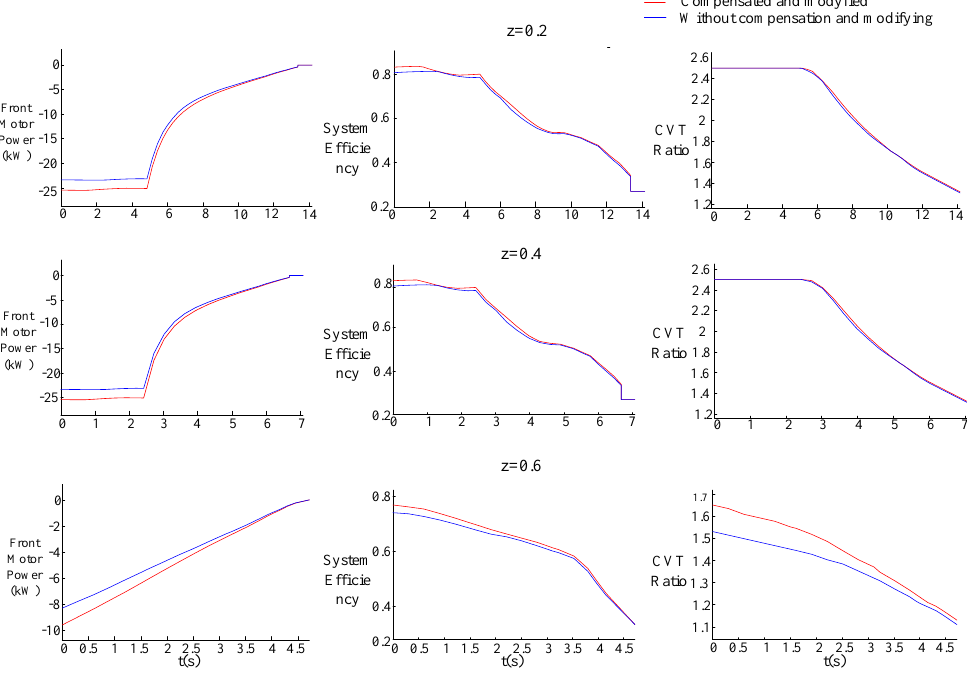
Figure 13. Simulation results in different braking strength.